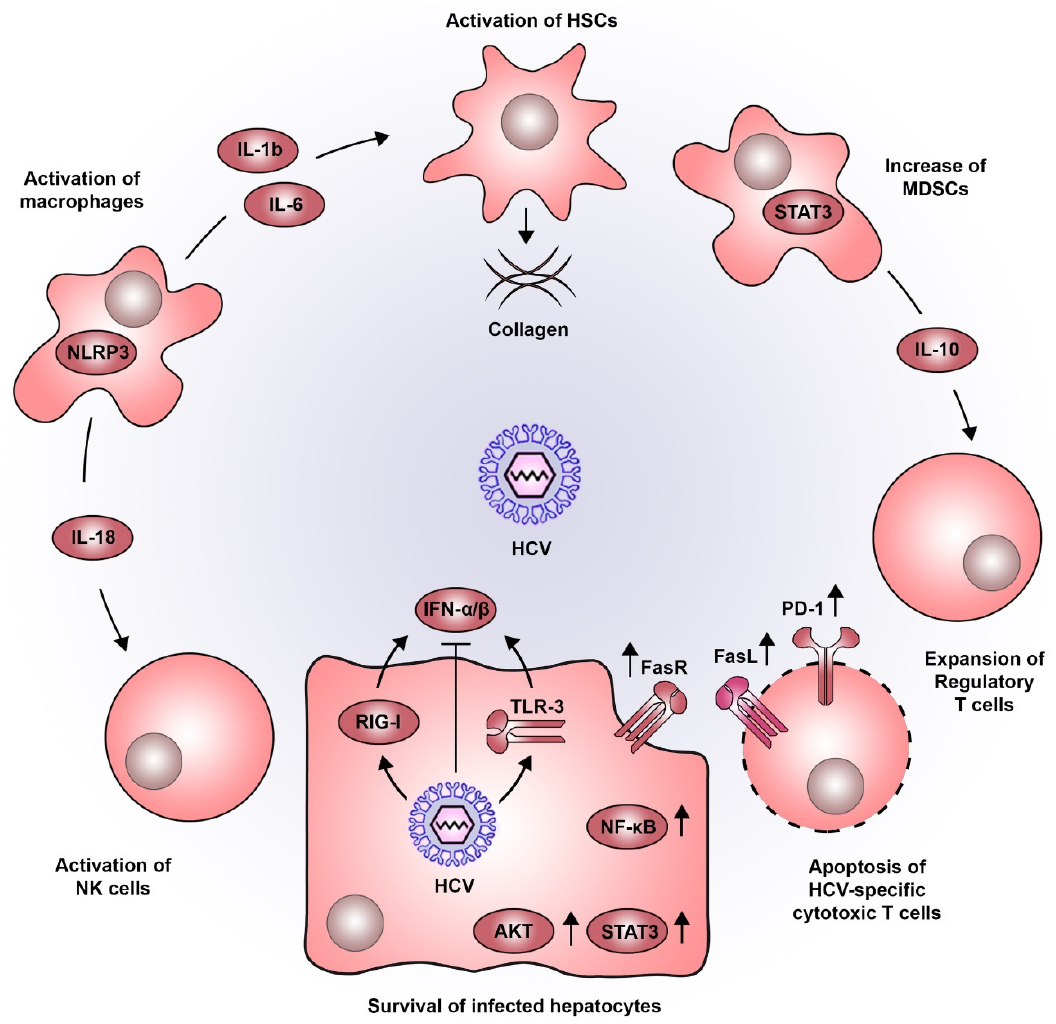
Figure 2. Pro-oncogenic inflammatory microenvironment induced by HCV. HCV infection in hepatocytes is detected by viral sensors such as RIG-I and TLR3, leading to the production of type I IFNs. As for most viruses, HCV has developed a wide variety of strategies to dampen this antiviral response. The persistent inflammatory environment in the liver combined with the action of viral proteins, establishes a sustained activation of signaling pathways associated to cell survival (e.g., STAT3, AKT, NF- κ B and FasR). The sensing of HCV-infected hepatocytes by macrophages triggers NLRP3 inflammasomes, inducing the secretion of IL-18 which activates NK cells. Moreover, IL-1b and IL-6 produced by macrophages favor the activation of HSCs which are central components in the progressive deposition of collagen associated to liver cirrhosis. Additionally, STAT3 also plays a role in the development of MDSCs which produce IL-10 and favor the expansion of regulatory T cells. This altered immune response, is further accentuated by the increased expression of PD-1 and FasL, impairing cytotoxic T lymphocyte function and inducing their apoptosis. Abbreviations: AKT, AKT serine / threonine kinase; FasL, Fas ligand; FasR, Fas receptor; HCV, hepatitis C virus; HSCs, hepatic stellate cells; IFN, interferon; IL, interleukin; MDSCs, myeloid-derived suppressor cells; NF- κ B, nuclear factor kappa B; NK, natural killer; NLRP3, NOD- LRR- and pyrin domain-containing protein 3; PD-1, programmed cell death 1; RIG-I, retinoic acid-inducible gene I; STAT3, signal transducer and activator of transcription 3; TLR3, toll like receptor